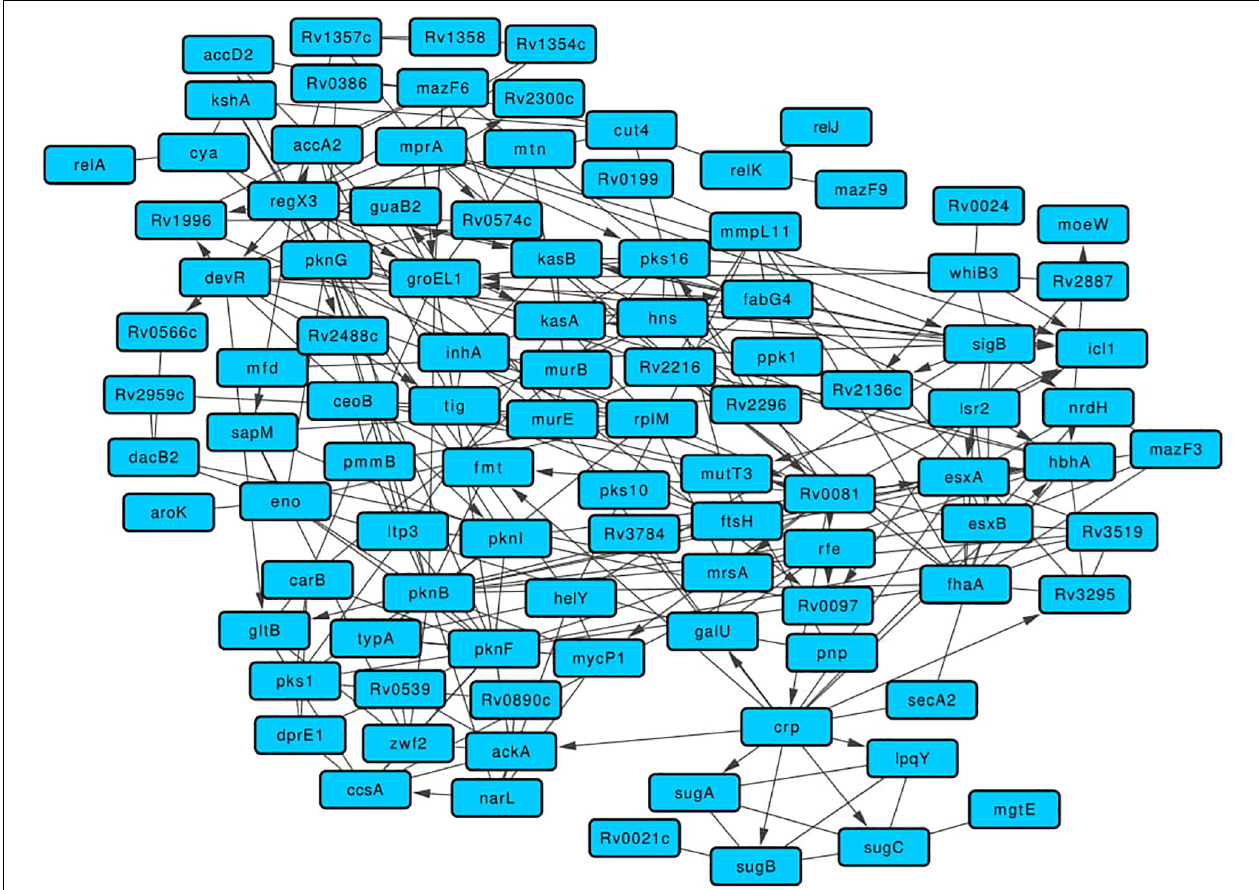
FIGURE 3 | Merged network comprising of protein-protein, gene regulatory, and expression correlation interactions for the